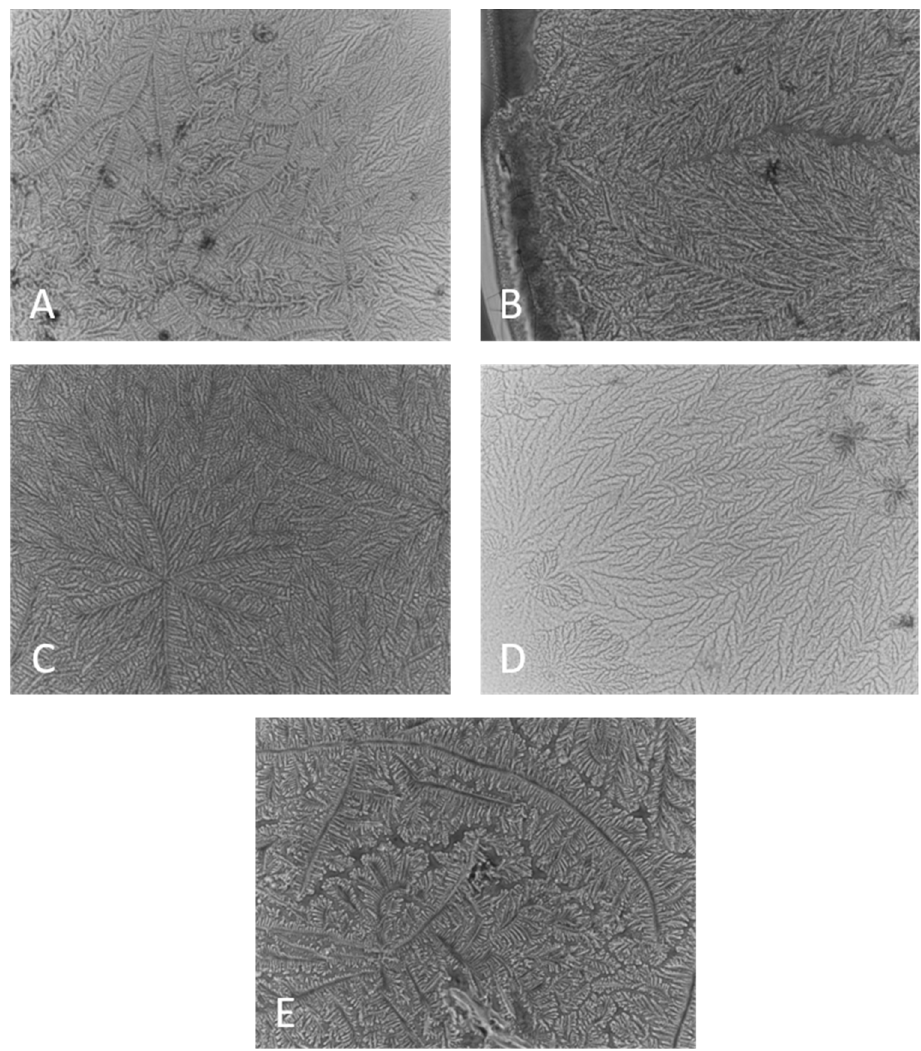
Figure 2. Ferning patterns observed after evaporation of microdroplets of human tears, alone and in the presence of MMP. ( A ) Pure tear, ( B ) Tears + 0.05% CHA, ( C ): Tears + 0.05% HA, ( D ) Tears + 0.05% CMC, ( E ) Tears + 0.05% GG. The field of view is 0.8 mm × 0.8 mm.